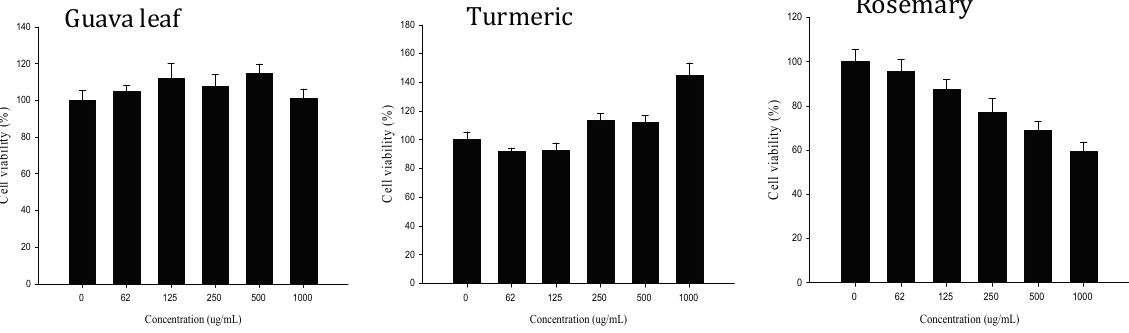
Figure 1. Effects of guava leaf, turmeric, and rosemary extracts on Caco-2 cell viability. Cells were incubated at different concentrations (0–1000 μ g/mL) of culinary plant extracts for 1 h, and cell viability (as % of control) was determined by using the MTT assay. Values represent the mean ±